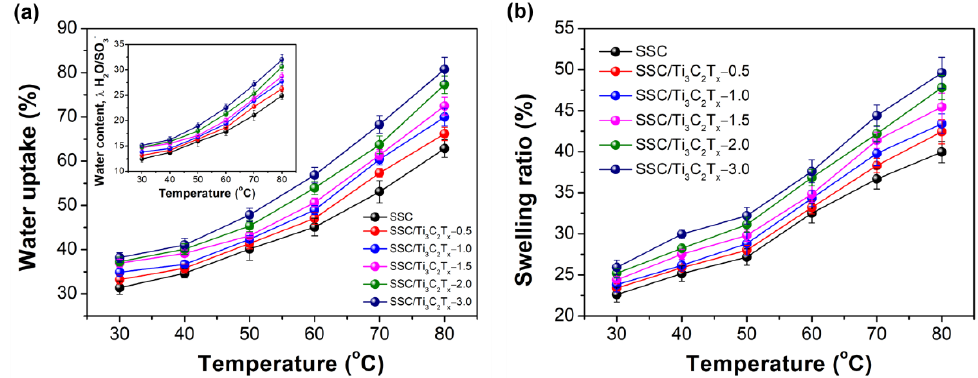
Figure 3. ( a ) Water uptake (the inserted figure is the water contents of membranes, λ) and ( b ) swelling ratio of the membranes in water as a function of